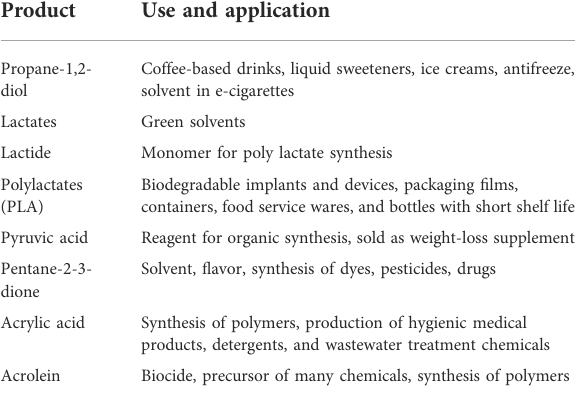
TABLE 6 Uses and applications of bio-derivatives from lactic